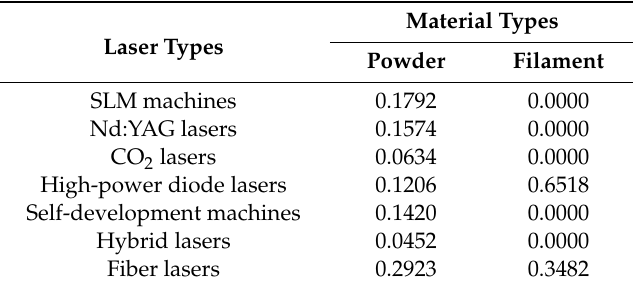
Table 1. Conditional probability tables CPT for X2: laser.